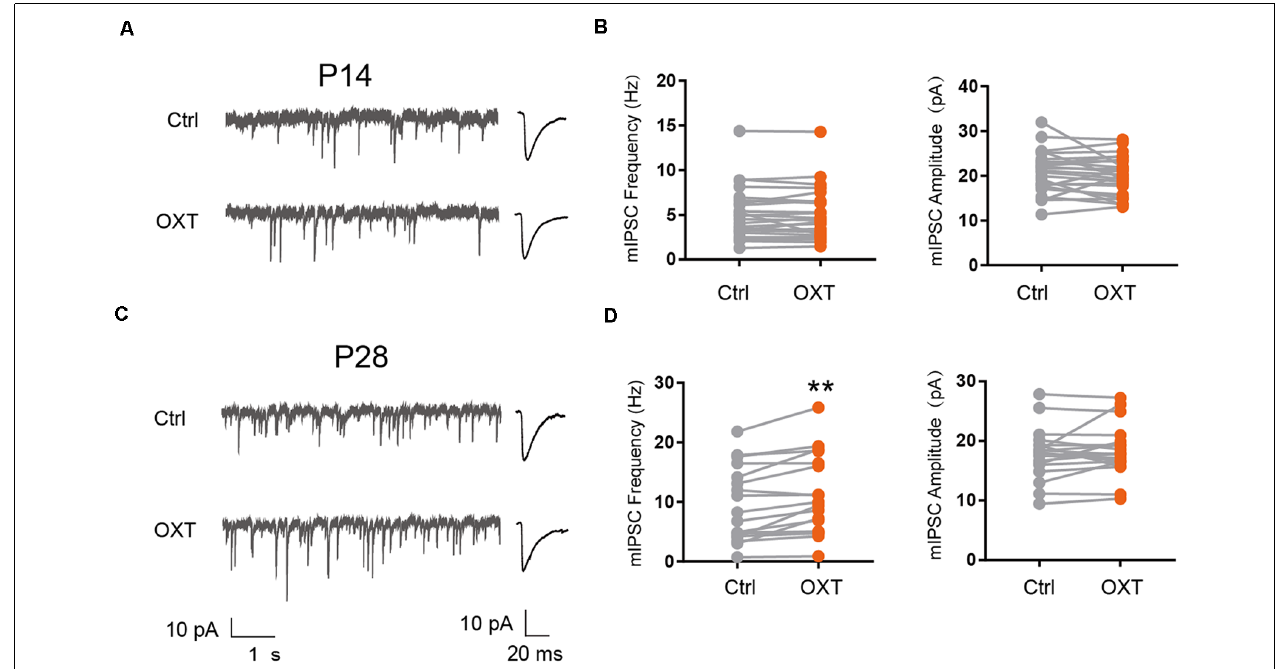
FIGURE 2 | Developmental effects of oxytocin application on inhibitory synaptic transmission. (A–C) Representative mIPSC recordings (left) and average waveforms (right) from S1BF L2/3 pyramidal neurons before (Ctrl) and after oxytocin (OXT) application, age as indicated. (B) Oxytocin application did not significantly affect mIPSC frequency or amplitude in P14 mice (frequency: Ctrl, 5.02 ± 0.58 Hz; OXT, 5.0 ± 0.58 Hz; n = 25; P = 0.87, paired t -test; amplitude: Ctrl, 20.82 ± 0.94 pA; OXT, 20.17 ± 0.85 pA; P = 0.31, paired t -test). (D) Oxytocin application increased mIPSC frequency but did not affect mIPSC amplitude in P28 mice (frequency: Ctrl, 9.17 ± 1.41 Hz; OXT, 10.77 ± 1.53 Hz; n = 19; ** P < 0.01, paired t -test; amplitude: Ctrl, 17.82 ± 0.99 pA; OXT, 18.38 ± 0.99 pA; P = 0.33, paired t -test). ** P <